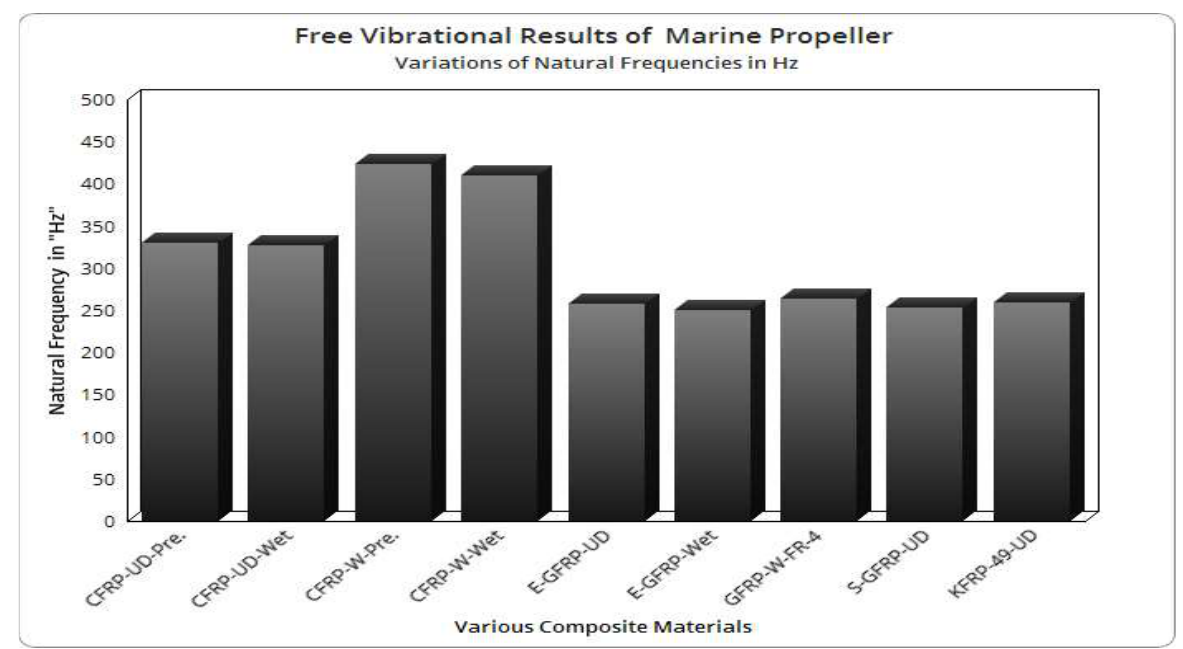
Figure 50. Free vibrational results of various composites based Marine Propeller.